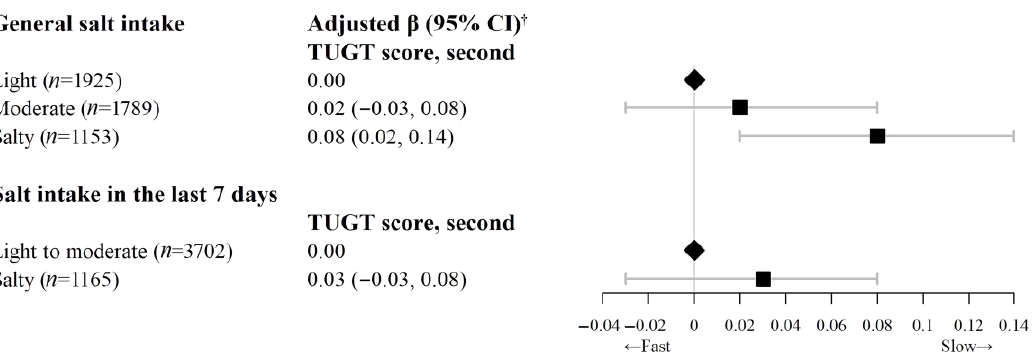
Figure 2. Association of salt intake with TUGT score (second) on 4867 participants of the Guangzhou Biobank Cohort Study. CI = confidence interval, TUGT = timed up-and-go test. † Adjusted β (95% CI): adjusted for sex, age, education, family income, occupation, physical activity, smoking status, alcohol use, body mass index (BMI), self-rated health, and self-reported hypertension.